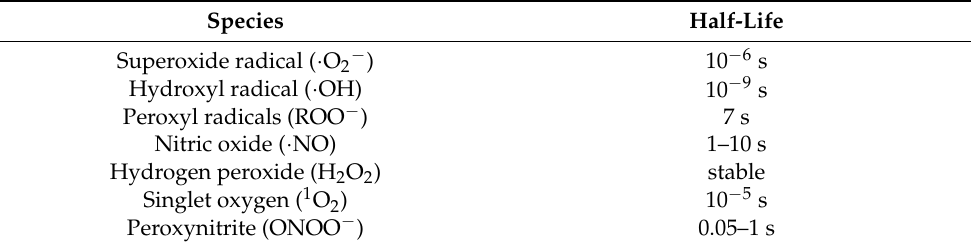
Table 1. RONS and their